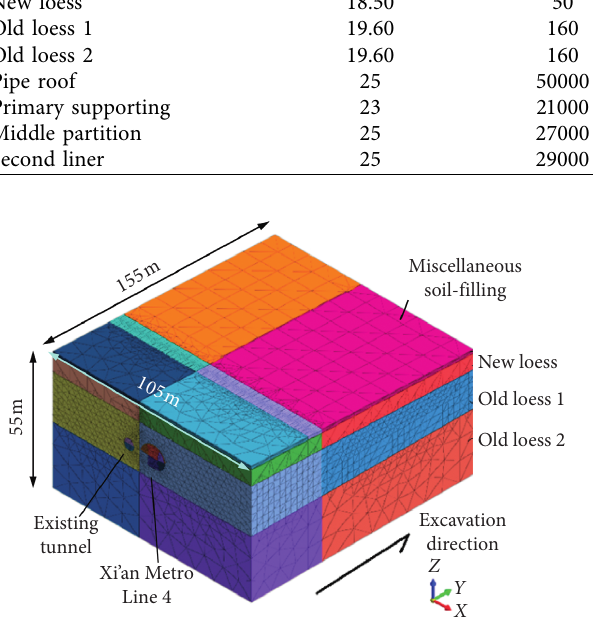
Figure 2: Model size and soil layer